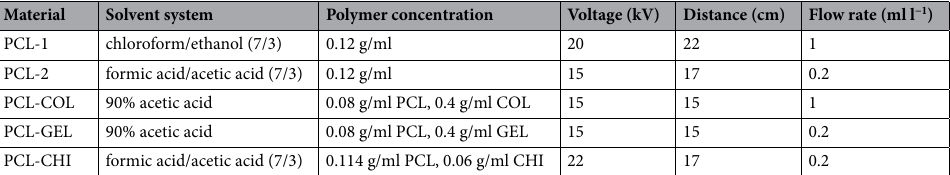
Table 1. Composition of the different scaffold materials. Electrospinning was performed on pure PCL from different solvent systems, resulting in various fiber diameters and on PCL-blends with collagen, gelatine and chitosan. Corresponding electrospinning parameters are